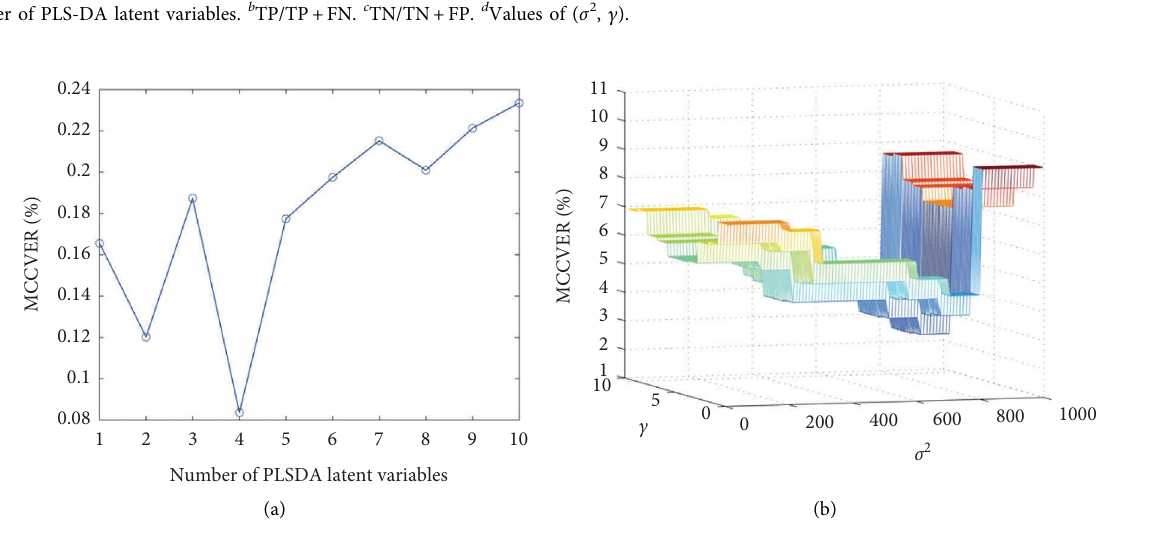
Figure 3: MCCV optimization of PLS-DA (a) and LS-SVM (b) model